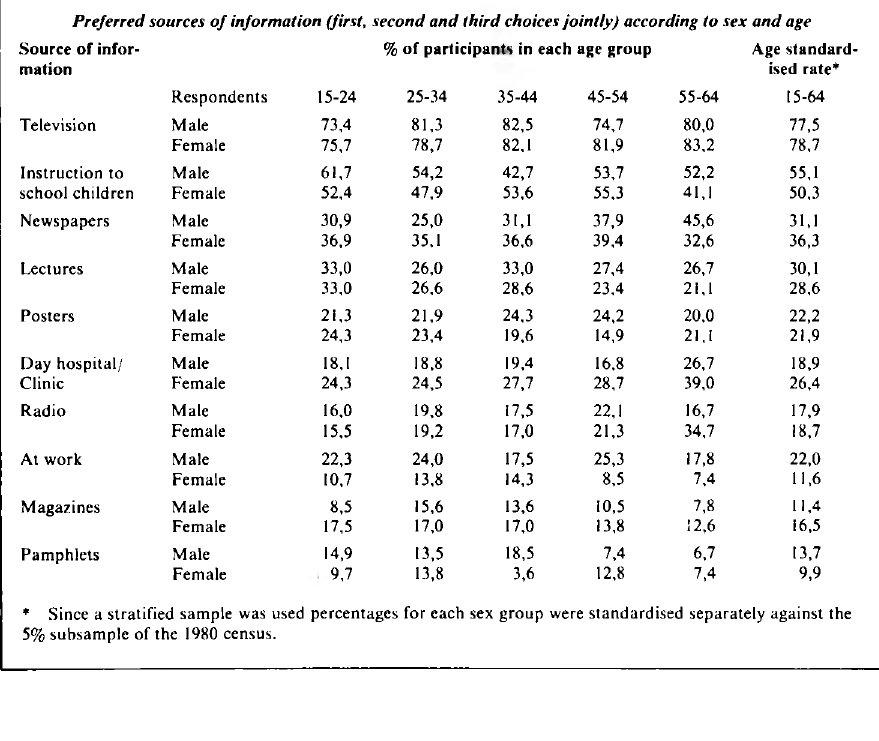
Preferred sources of information (first, second and third choices jointly) according to sex and